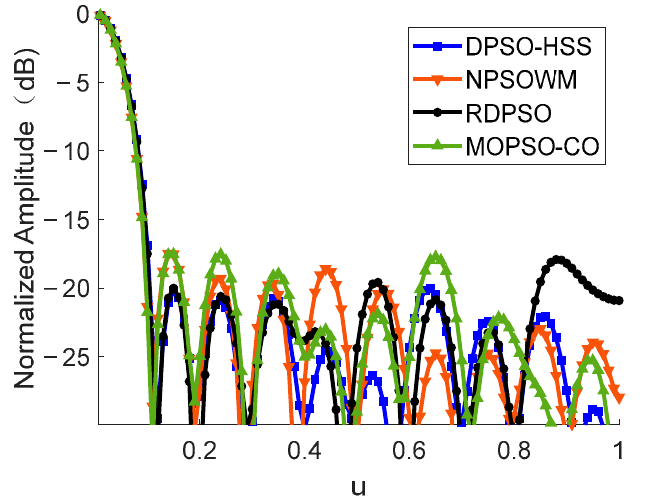
is decreased by 6.82%, 5.17%, and 3.74%, respectively.